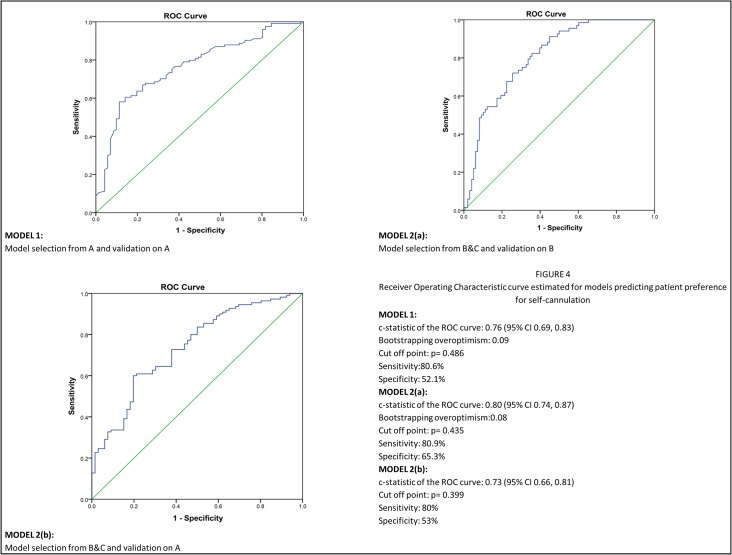
Graphs depicting the Receiver Operating Characteristic (ROC) curves for two models predicting patient preference for self-cannulation.